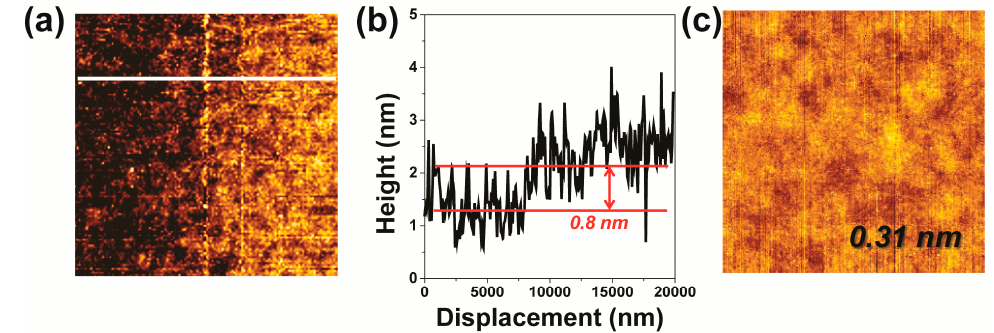
Figure 5. Analysis of the wear track of 12L MoS 2 . ( a ) A 2 µm × 2 µm AFM image obtained from the region of the sample corresponding to the black box shown in Figure 4c. ( b ) Surface height profile of the slice of the sample corresponding to the white line in panel ( a ). ( c ) A 500 nm × 500 nm AFM image obtained from the wear track (white box in Figure 4c). The RMS roughness value of the worn area of the sample is indicated.